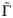
Analytically computed upper and lower boundaries to the MC-HD shock phase, depending on Γ˜ for L = 1.The green line represents the lower boundary β˜l* and the blue line corresponds to the upper boundary β˜u*. The horizontal red dashed line serve as illustration. The intersections (at β˜=0.1) with β˜l* and β˜u* indicate the values of the drop-off rates at which an mRNA with termination rate β˜=0.1 would undergo a transition from HD to SP, and from SP to MC, respectively.